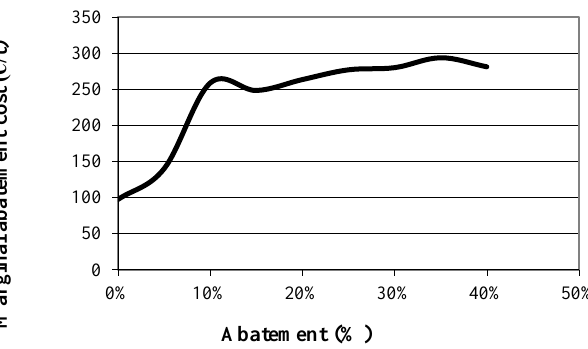
Figure 5. Marginal abatement cost curve of the intensive farm.